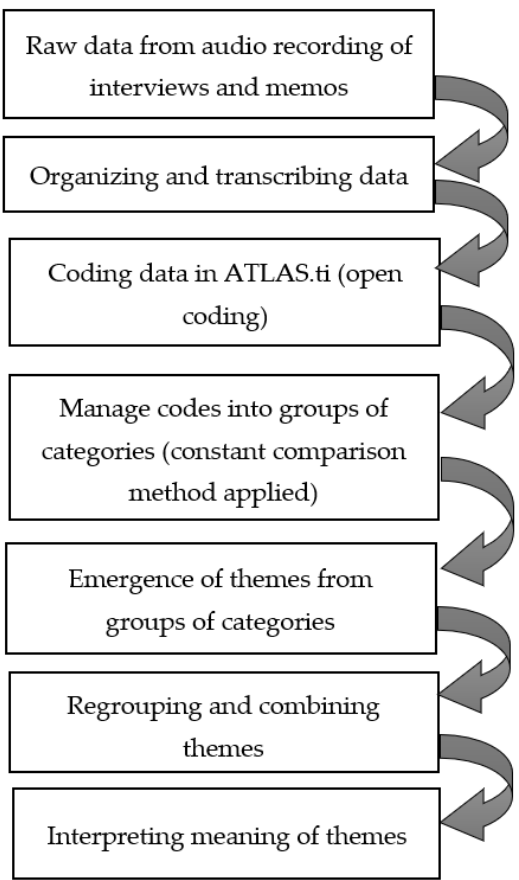
Figure 1. Summary of thematic analysis of data.